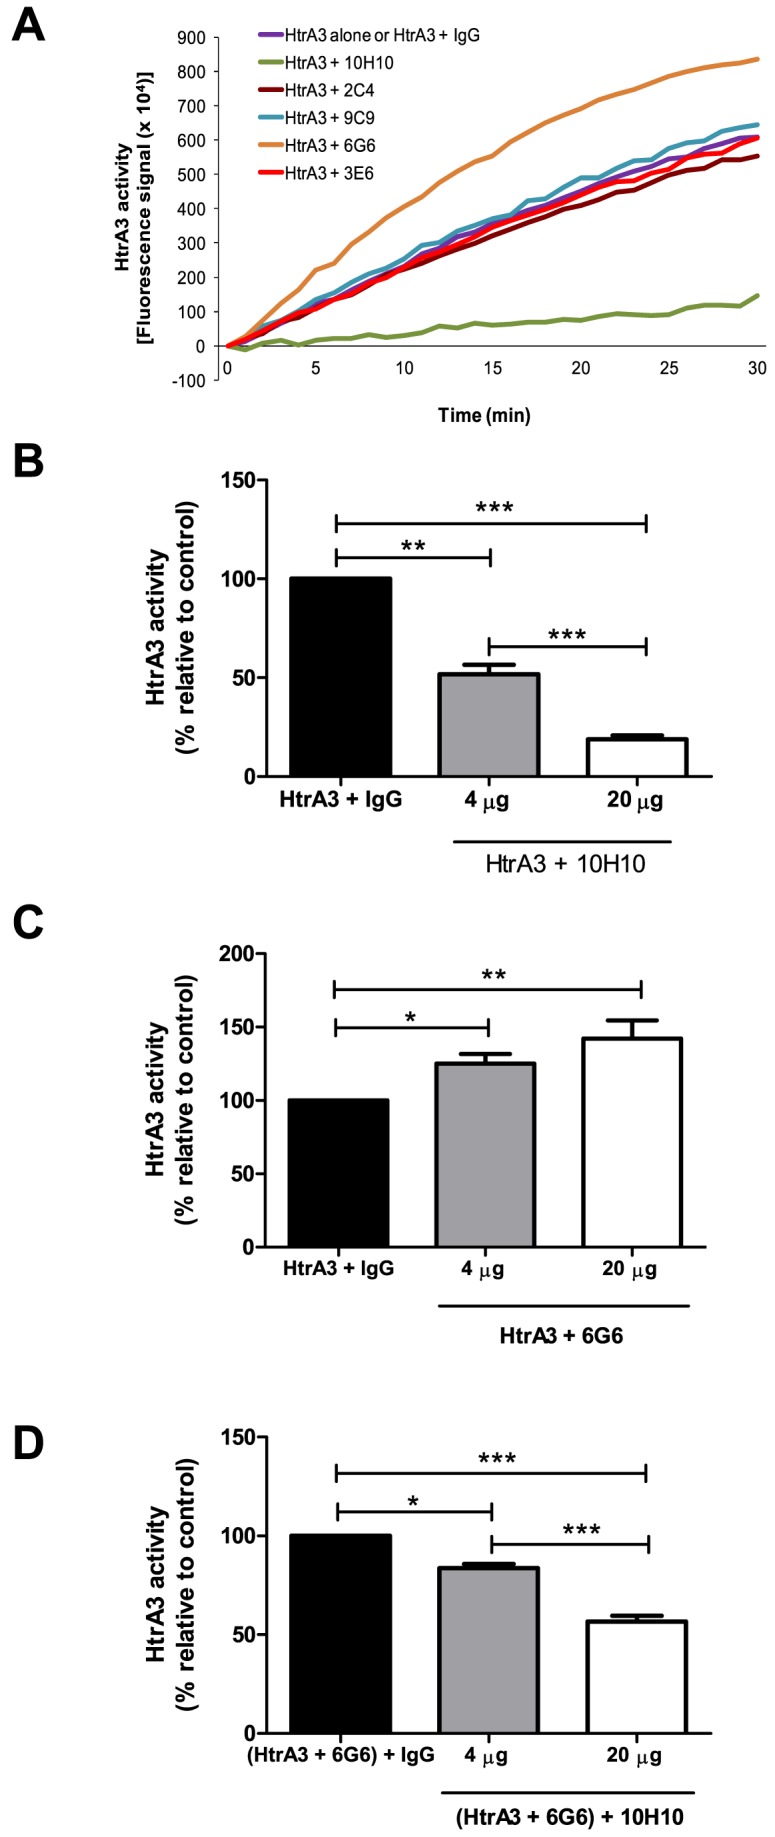
Effects of HtrA3 mAbs on substrate cleavage and dose-dependent modulation of HtrA3 activity by mAbs.(A) Representative real-time progressive curves of substrate cleavage by recombinant wild type human HtrA3 (HtrA3-L) in the presence of 20 µg/ml individual HtrA3 mAb (6G6, 9C9, 10H10, 3E6 and 2C4) or control mAb. (B) Inhibition of HtrA3 activity by mAb 10H10. (C) Enhancement of HtrA3 activity by mAb 6G6. (D) Inhibition of HtrA3 activity by mAb 10H10 subsequent to 6G6 stimulation. The data are expressed as changes in the rate of substrate cleavage relative to the control (B & C: control  =  HtrA3 with IgG control mAb, D: control  =  HtrA3 with mAb 6G6 at 20 µg/ml). Data are mean ± SEM from 3 independent experiments, *, P<0.05, **, P<0.01, ***, P<0.001.